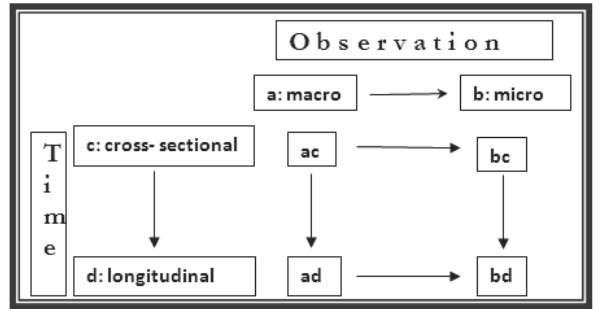
Figure 1 – Types of demographic approach. Source: Santini, 1999, p.